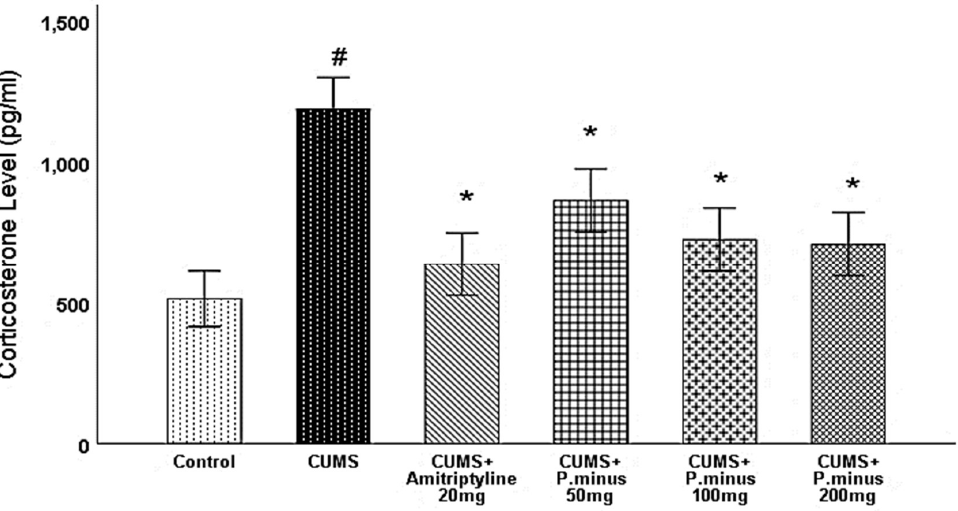
Figure 7. Effects of P. minus aqueous extract on serum corticosterone level (pg/mL) in CUMS induced depressive mice. # ( p < 0.05), vs. Control group; * ( p < 0.05), vs. CUMS group, ( n = 6).